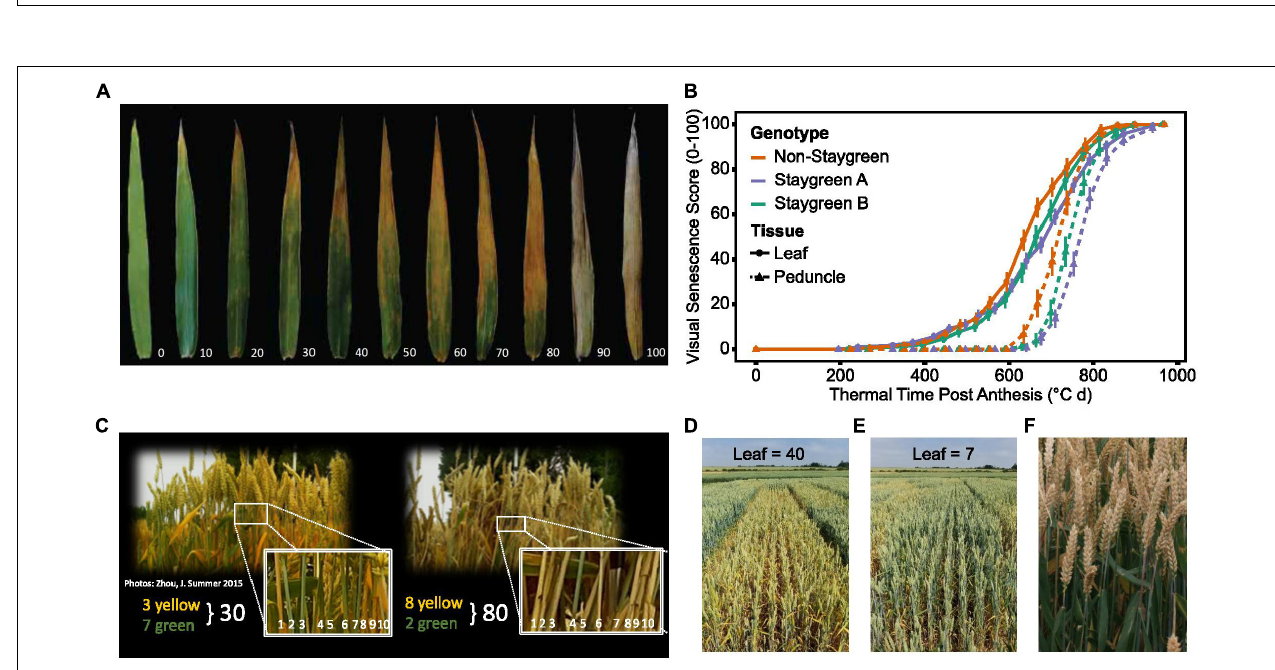
FIGURE 3 | Simultaneous scoring of flag leaf, peduncle, and ear senescence allows the whole plant nature of senescence to be considered. Compared to flag leaf senescence (A) , scoring of peduncle senescence (C) is less subjective, and respective senescence profiles were found to reinforce one another (B) . Senescence of multiple plants was visually assessed and scored using a 0–100 scale (A,C) at the plot level (D,E) , taking care to avoid edge effects or diseased plants. When observed, asynchronous senescence phenotypes (F) were recorded and may indicate impaired remobilization efficiency.